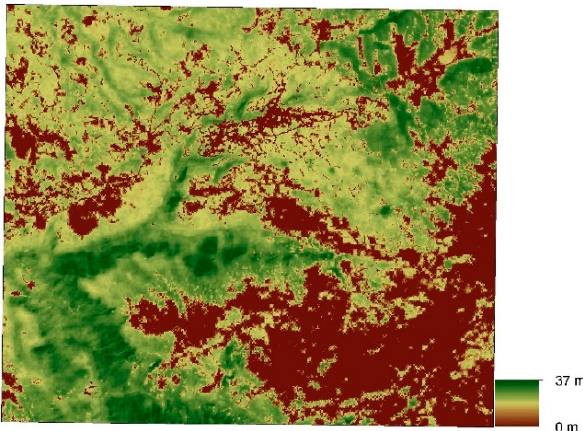
Figure 3. Canopy height map .